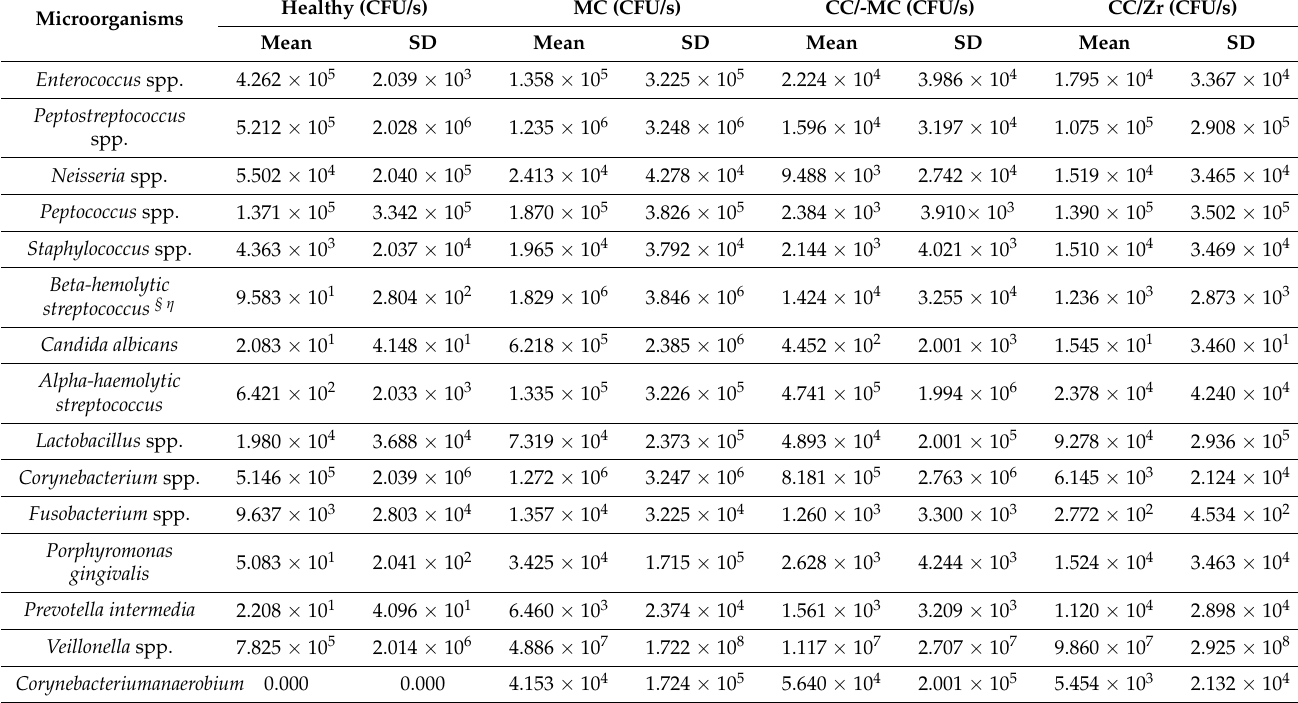
Table 3. Microbiologic composition and counts of the GCF in all groups at six months of prosthetic treatment. Microorganisms